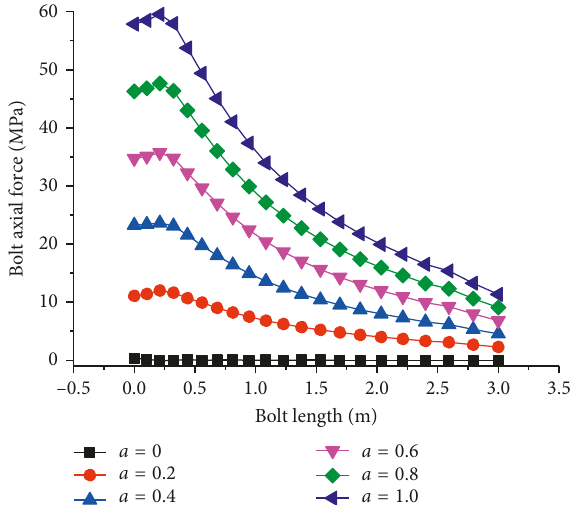
0.2, (b) α 0.4, (c) α 0.6, and (d) α 0.8. (cid:29) (cid:29) (cid:29) (cid:29)